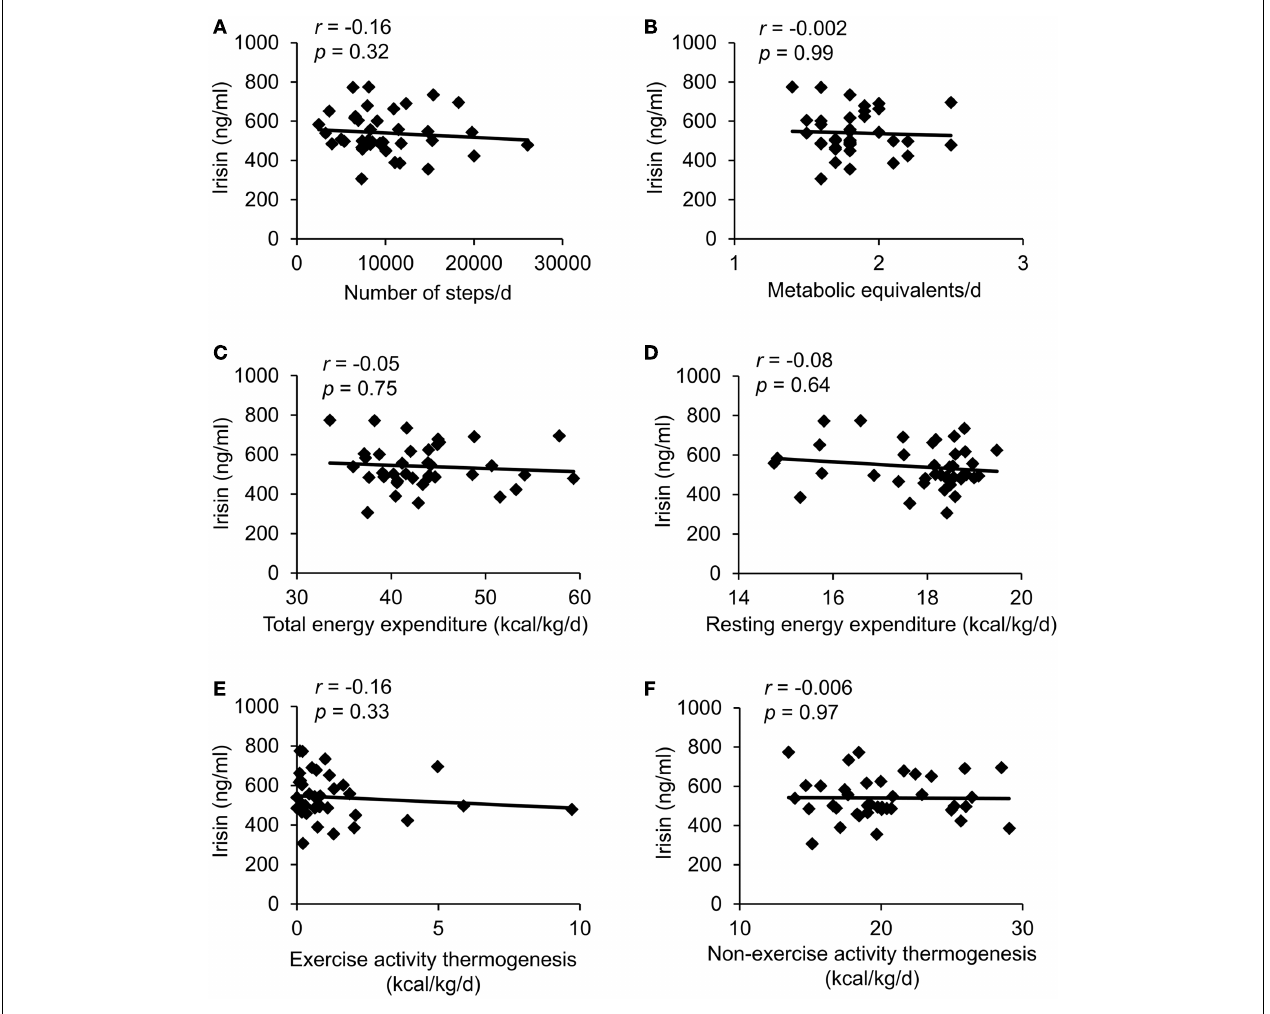
FIGURE 2 | Correlations between circulating irisin concentrations and number of steps per day (A), metabolic equivalents per day (B), body weight-adjusted total energy expenditure (C), body weight-adjusted resting energy expenditure (D), body weight-adjusted exercise activity thermogenesis (E), and body weight-adjusted non-exercise activity thermogenesis (F) .Values for r and p are indicated in each graph, n = 39